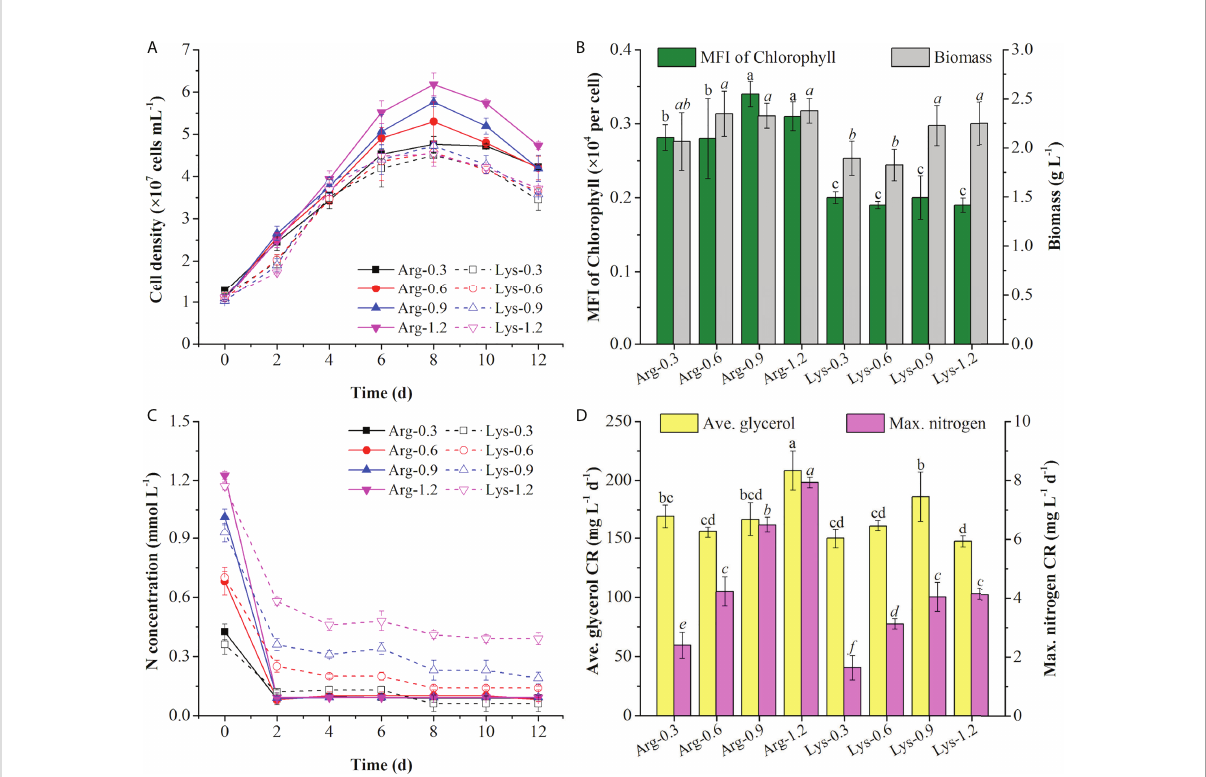
FIGURE 4 Cell density (A) , mean fl uorescence intensity (MFI) of chlorophyll and biomass concentration (B) , nitrogen concentration (C) , and average (ave.) glycerol consumption rate and maximum (max.) nitrogen consumption rate (D) using arginine (Arg) and lysine (Lys) at 0.3, 0.6, 0.9, and 1.2 mmol N L − 1 in the mixotrophic medium. Different letters indicate a signi fi cant difference ( p<